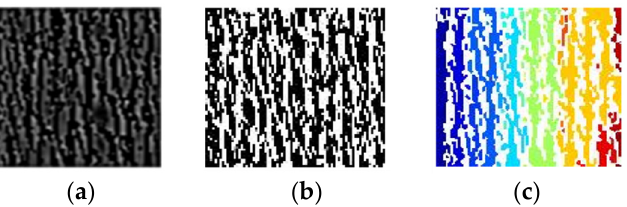
Figure 4. The examples of the generated image from bearing vibration with normal conditions are ( a ) the grayscale image, ( b ) the binary image, and ( c ) the RGB-based colour image [36].